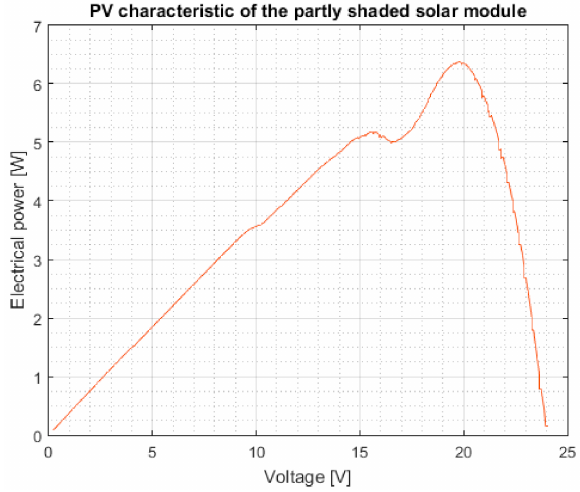
Figure 6. PV of a solar module in partly shaded conditions. More local MPPs are visible. The maximum power cannot be gained from the solar module without the use of the MPPT, which is located between the solar module and battery on the other side, as shown in Figure 7. The MPPT usually consists of a DC/DC switcher regulator in combination with an additional circuit or device with MPPT functionality.